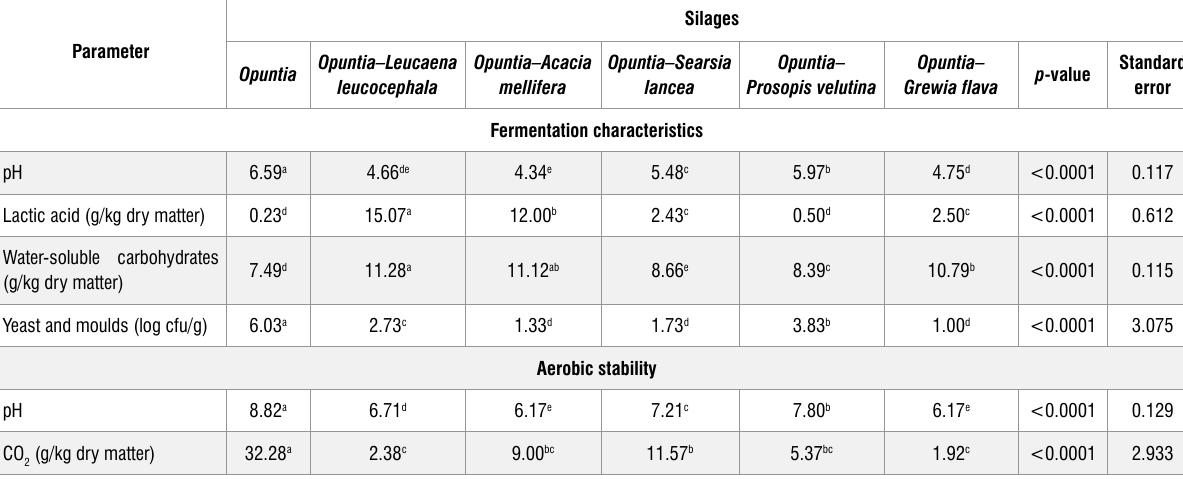
Table 3: Fermentation characteristics and aerobic stability of the silages used in the experiment